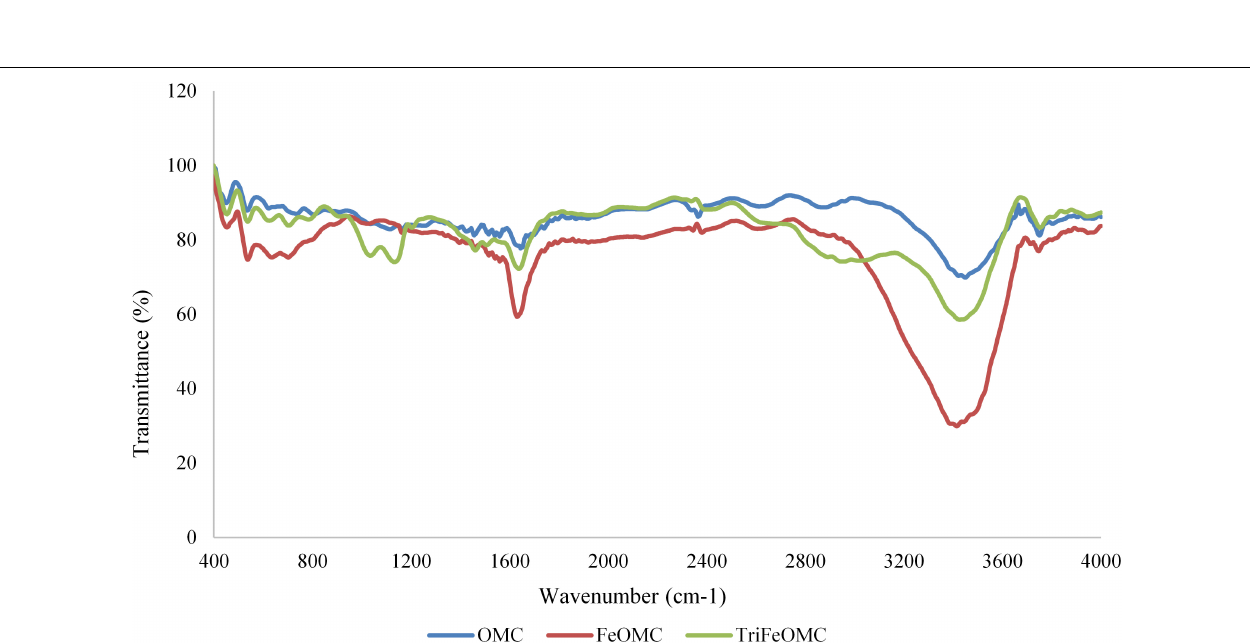
FIGURE 7 | FTIR spectra of OMC, FeOMC, and TriFeOMC showing two major band ranges.